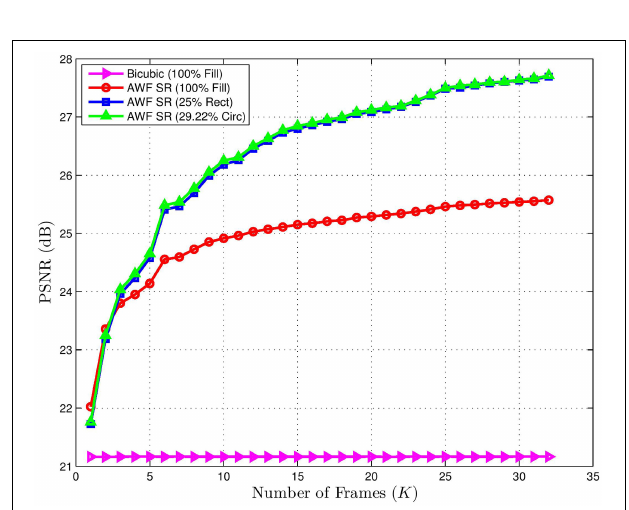
FIGURE 23 | PSNR for K = 16 multiframe AWF SR for the 8 bit motocross image (kodim05.png) with ¯ f = 82 . 65 vs. signal scaling parameter s . Note that s governs the effective noise variance as shown in Equation (8). The system parameters are the Q = 0 . 50 row in Table 1 . For all but the lowest signal levels, the reduced fill factor detectors produce the highest PSNR results after SR processing. A similar trend is seen with all of the images tested.